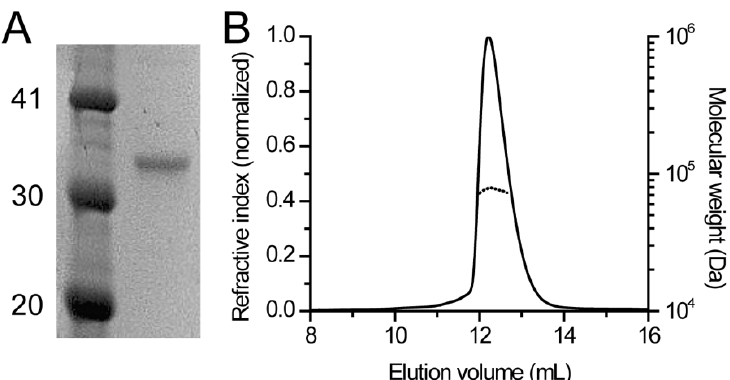
Figure 2. Human DHDDS forms monodisperse homodimers. ( A ) SDS-PAGE analysis of purified DHDDS. Left lane, molecular weight marker; right lane, purified DHDDS. Numbers indicate weight in kDa. ( B ) SEC-MALS analysis of purified DHDDS. The solid line represents the normalized refractive index and the dashed line represents the calculated molecular weight in Da.